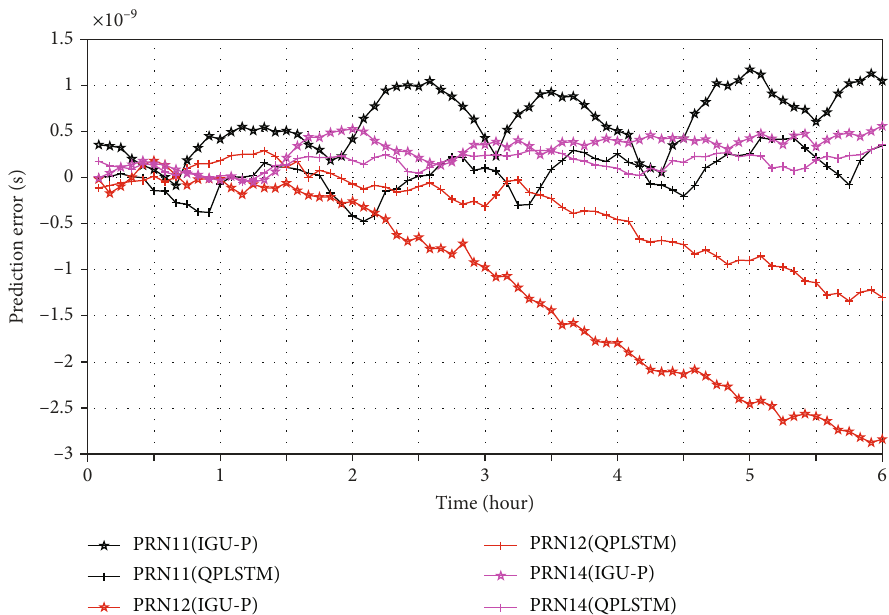
Figure 6: Prediction residuals for IGU-P and QPLSTM for BDS2-MEO-Rb.